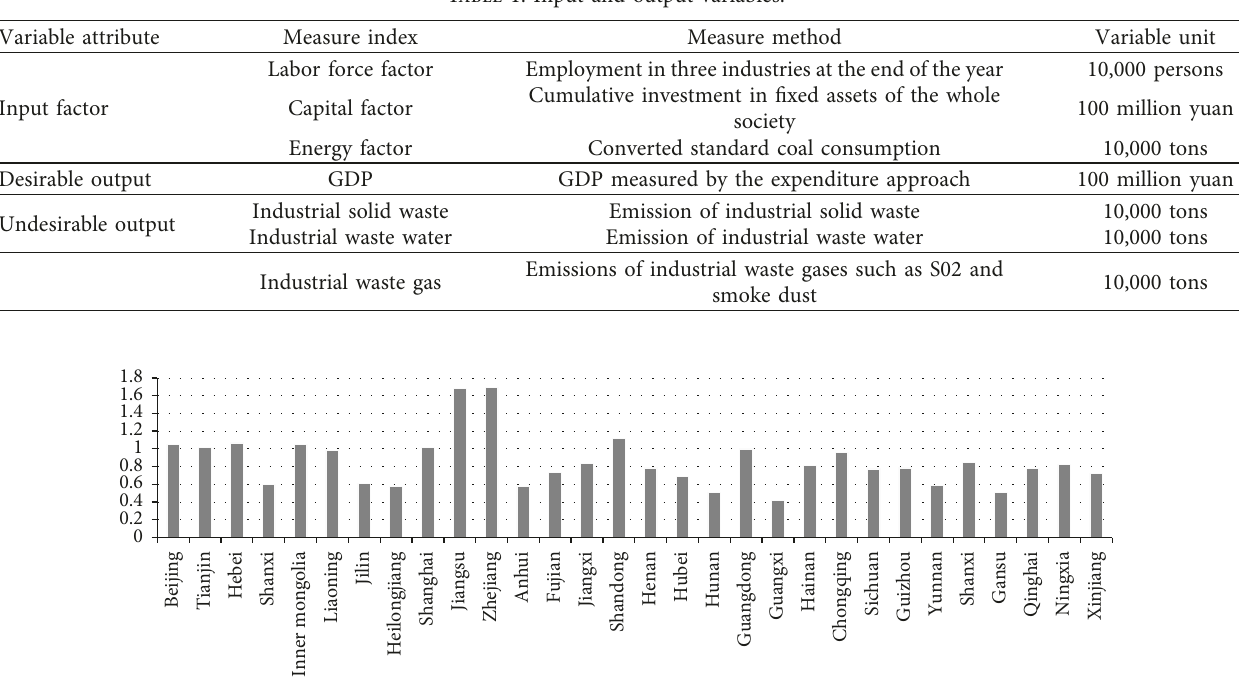
Figure 1: Average TFP